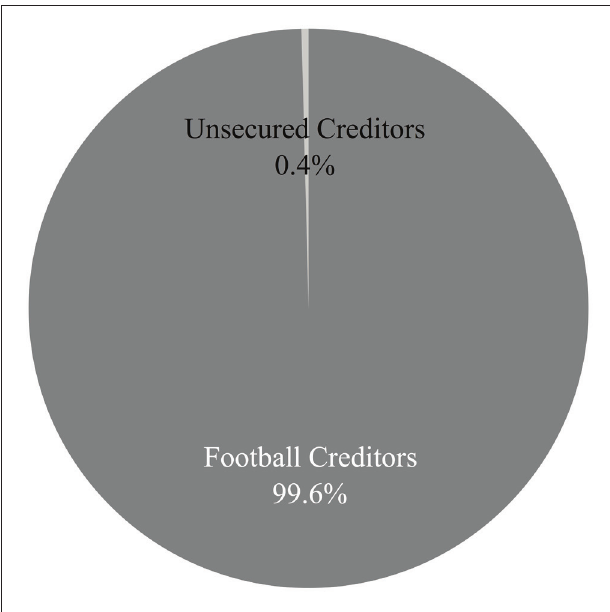
Figure 4: Plymouth Argyle (2011) Payment